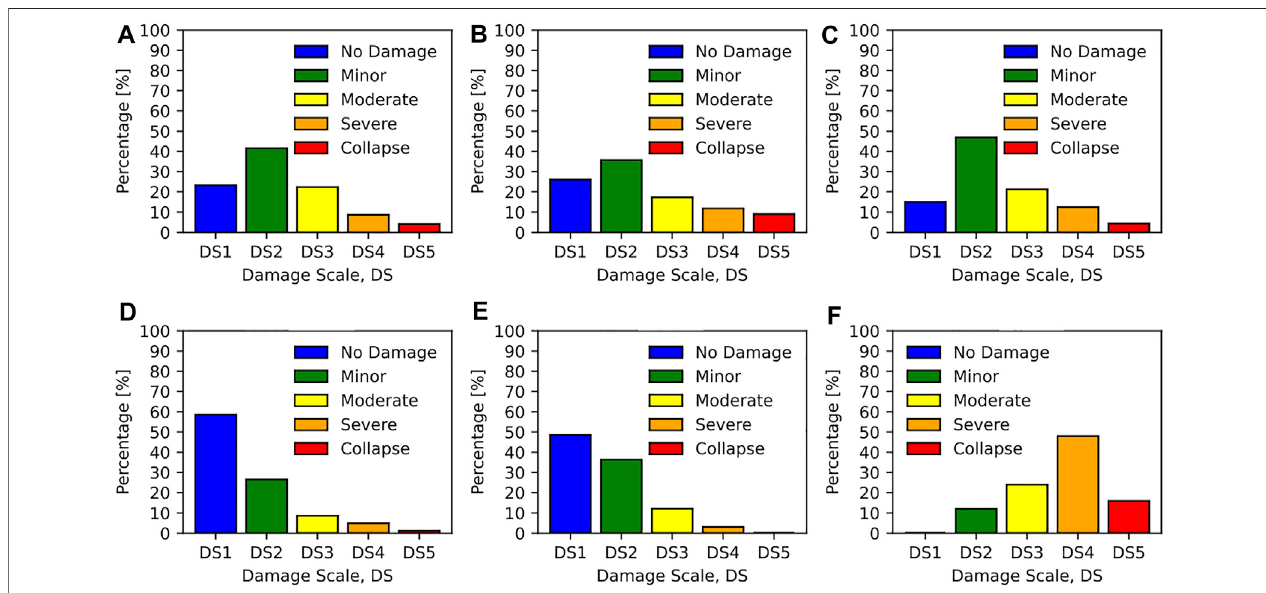
FIGURE 12 | Distribution of damage grades for (A) reinforced concrete, (B) con fi ned masonry, (C) unreinforced masonry, (D) reinforced masonry, (E) wood light frame and (F) wood schools with stone in fi ll.